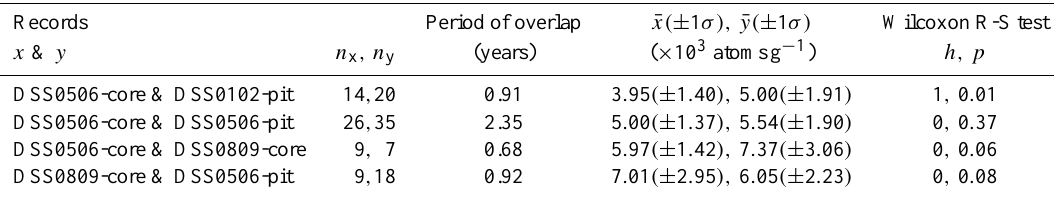
Table 2. Inter-comparison of contemporaneous sections of 10 Be records from DSS, Law Dome. A Wilcoxon rank-sum hypothesis test (see text) is used to test for significant difference between the pairs of records ( h = 0 implies no evidence that the records are significantly different at the 95% CI, i.e., where p < 0 .